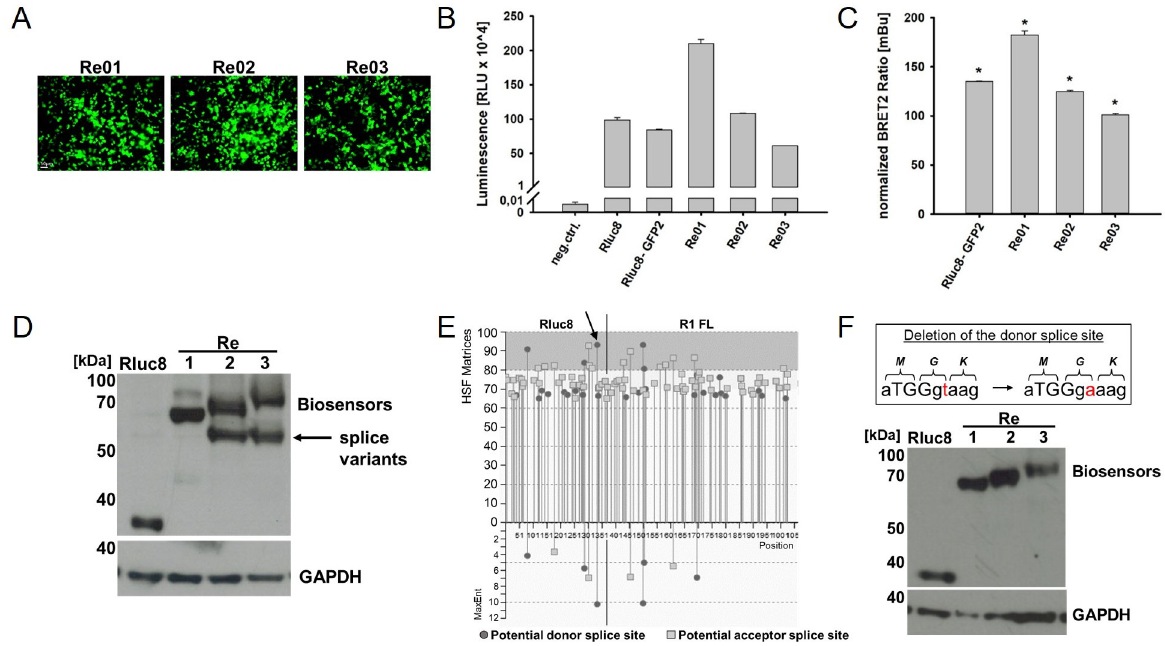
Fig 2. Characterization of eBRET2 biosensor expression. (A) Fluorescence microscopy of GFP2 expression after biosensor plasmid transfection in HEK293 T cells. (B) Luciferase activity via Luminescence measurement. Rluc8 expression correlates with Luciferase activity. (C) eBRET2 ratios of the biosensor variants normalized with the correction factor (Rluc8 29.8 ± 0.3 mBU). Significance defined as p < 0.001. (D) Western Blot shows full length expression of the biosensors and correction factor (Rluc8 alone). 1. Antibody: anti Rluc8 (1:1000) on the top and anti GAPDH (1:1000) on the bottom. 2. Antibody: anti Rabbit HRP (1:20000). Arrow indicates additional bands that show extra splice variants. (E) Splice prediction with Human Splicing Finder 3.0 software. Circles represent donor sites, squares represent acceptor sites, and strongest candidates are located in the grey area. Arrow marked the strong donor splice site in the Rluc8. (F) Western Blot after deletion of the splice site shows full length expression of the biosensors and correction factor (Rluc8 alone). No splice variants could be detected. The box shows the base sequence of the splice site with one letter code for the corresponding amino acids above. In red marked the change of the thymine base into an adenine base to delete the splice site. The amino acid sequence did not change.